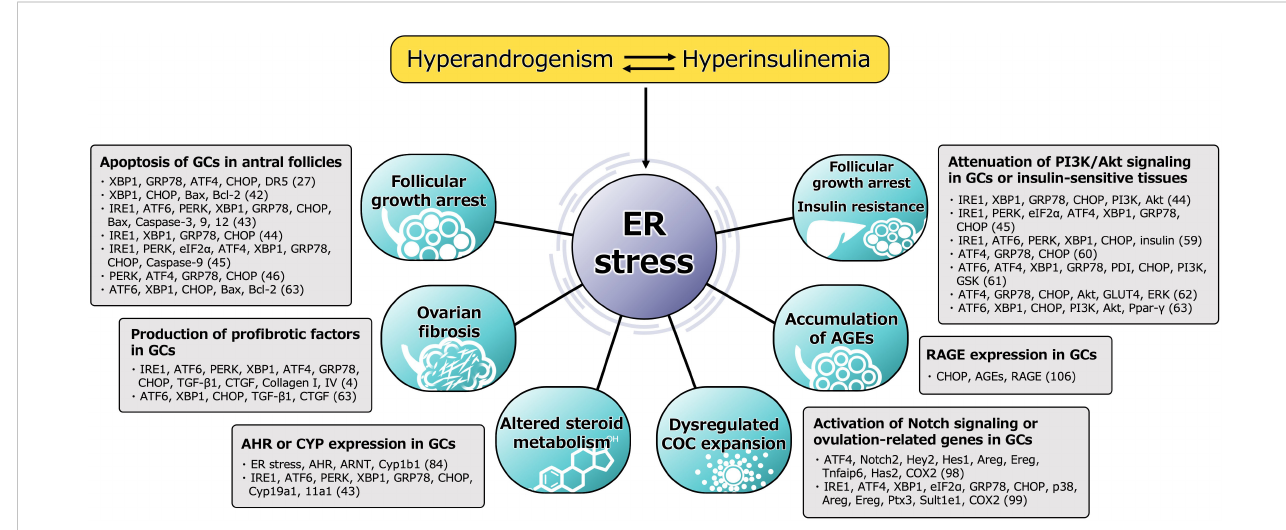
FIGURE 2 Functional alteration of GCs induced by ER stress in pathophysiology of PCOS. Molecules involved in the mechanism, either directly or indirectly activated by ER stress, are shown. The number in parentheses refers to the reference number of citation. ER stress is activated in the follicular microenvironment by HA and IR, two key factors underpinning the heterogenous etiology of PCOS. ER stress and the subsequent activation of the UPR contribute to the pathophysiology of PCOS by impairing the function of GCs in multiple ways. ER stress activates the apoptotic cascade in GCs and is associated with follicular growth arrest. The UPR branches, PERK-ATF4-CHOP or IRE1-TRAF2-JNK, induce several caspases-dependent apoptosis. ER stress also induces the ovarian fi brosis that is characteristic of PCOS by increasing the production of pro fi brotic cytokines, such as TGF- b 1 and CTGF, in GCs via the UPR pathway, especially involved in XBP1. ER stress is also associated with high expression of AHR, AHR nuclear translocator (ARNT) and its downstream Cyp1b1 in GCs, which causes alterations in ovarian steroid hormone metabolism. In addition to this, other steroidogenic enzymes, such as Cyp19a1 and Cyp11a1, are induced by the UPR pathway. ER stress also perturbs COC expansion via activation of ATF4 and Notch signaling followed by the induction of ovulation-related genes, such as amphiregulin (Areg), epiregulin (Ereg), hyaluronan synthase 2 (Has2), tumor necrosis factor alpha- induced protein 6 (Tnfaip6) and cyclooxygenase 2 (COX2), in GCs, which might also contribute to the ovulatory dysfunction. ER stress is also associated with the accumulation of AGEs in GCs and an increase in expression of the RAGE through induction of CHOP, resulting in a failure of follicular development. In addition, ER stress in the pancreas, liver, muscle, and adipocytes induces IR and compensatory hyperinsulinemia, which aggravate HA and directly contribute to ovarian dysfunction by impairing PI3K/Akt signaling in GCs. Thus, a vicious circle is formed by HA, hyperinsulinemia, and other proin fl ammatory factors, and these factors are connected through ER